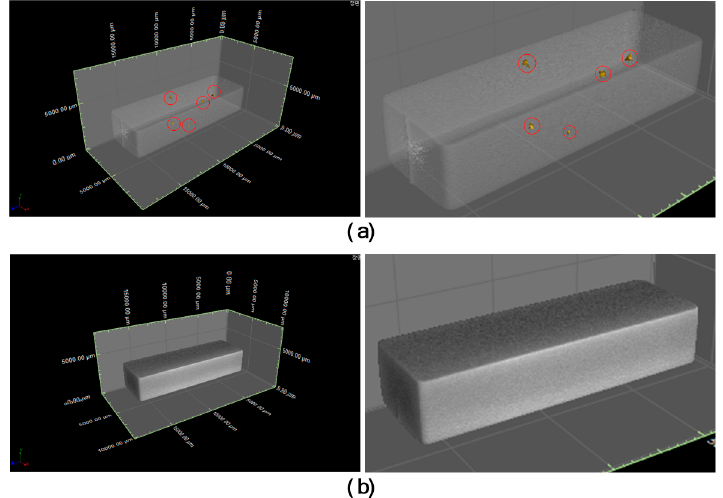
Figure 12. The specimen image after the density measurement test: ( a ) Void state images before heat treating the AM specimen of the HWS powder material; ( b ) Void state images after heat treating the AM specimen of the HWS powder material.